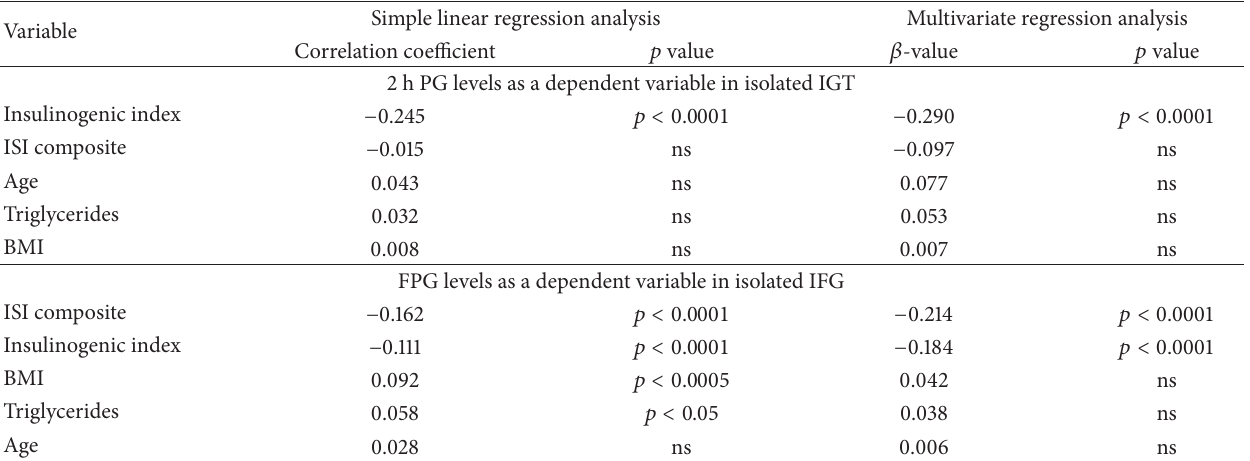
Table 2: Factors responsible for elevating FPG levels in isolated IFG and 2 h PG levels in isolated IGT. Variable